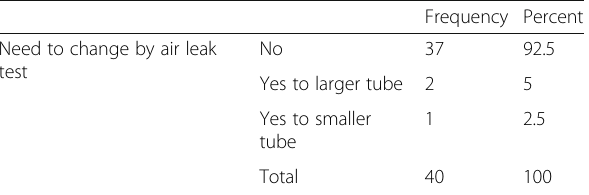
Table 4 Frequency and percentage of ETT change according to air leak